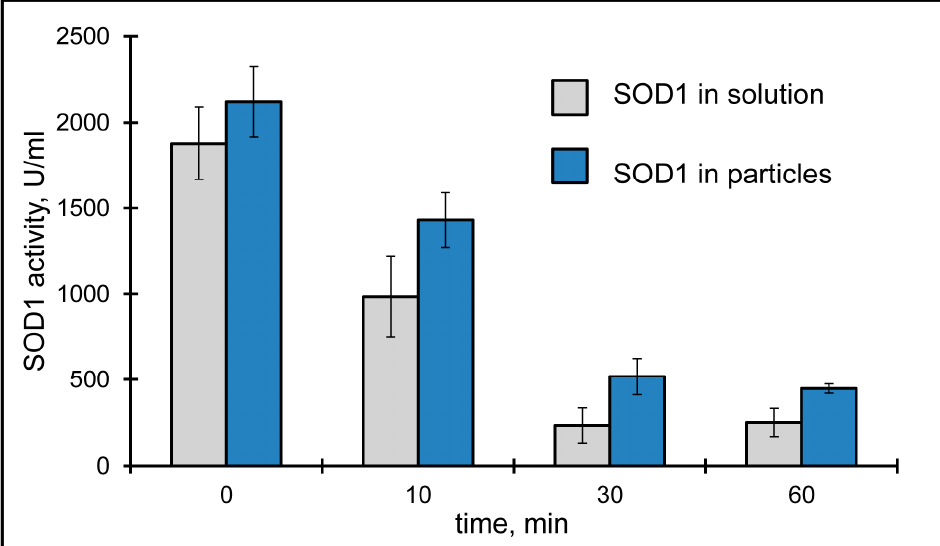
Figure 4. SOD1 activity in lacrimal fluid after single instillation of SOD1-containing hybrid particles (blue) and SOD1 solution (grey).